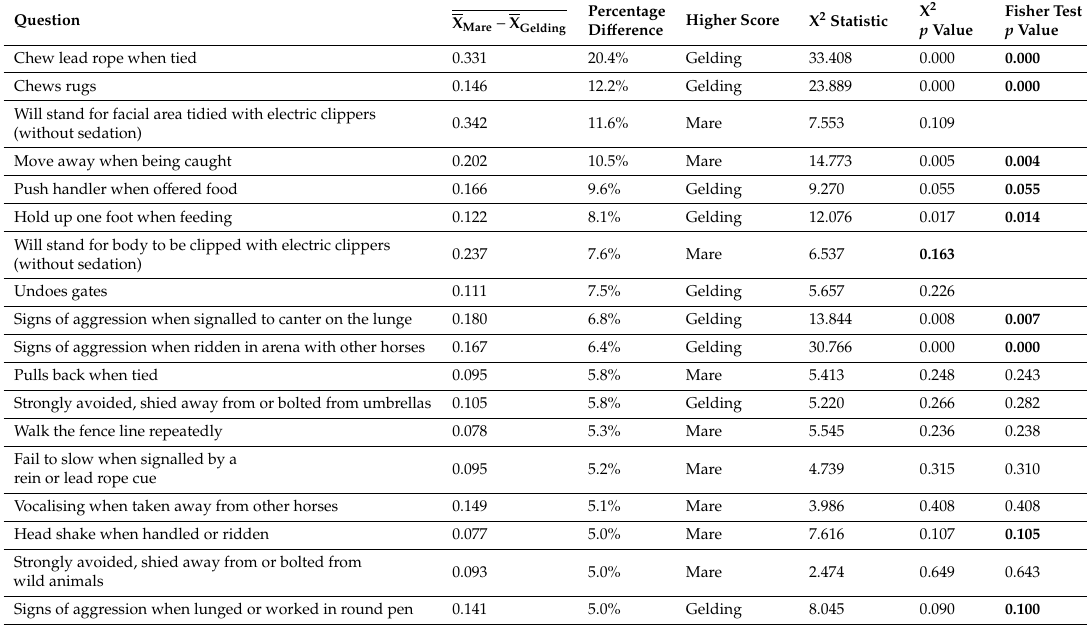
Table 1. The traits with more than 5% percentage di ff erence scores between mares and geldings, selected among the 151 candidate items reported on in full by respondents (n = 1233). Traits with univariate p values < 0.2 on a χ 2 test (or Fisher’s exact test) were selected for further